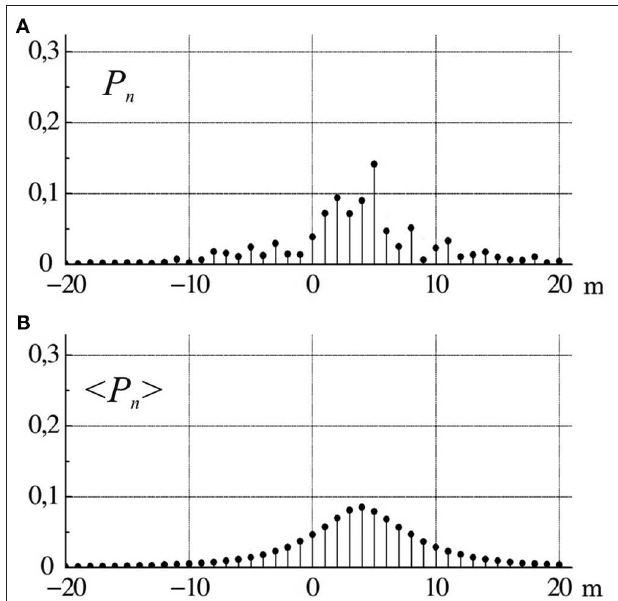
FIGURE 10 | Spectrum of angular harmonics of the beam LG 4 0 upon passage of the pathlength z 2000m in the medium with the Rytov index β 2 0 = (A) random realization, (B) averaging over 5000 realizations.